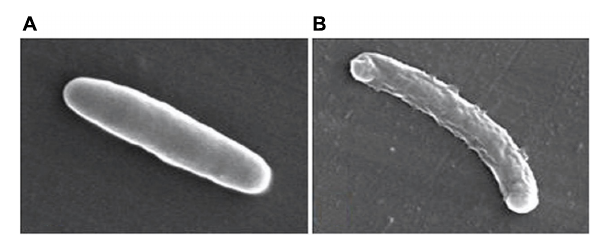
FIGURE 2 | Control P. aeruginosa cells (A) and cells treated with complex 16 (B) . Reproduced from Samanta et al. (2013) (CC BY-NC 4.0).